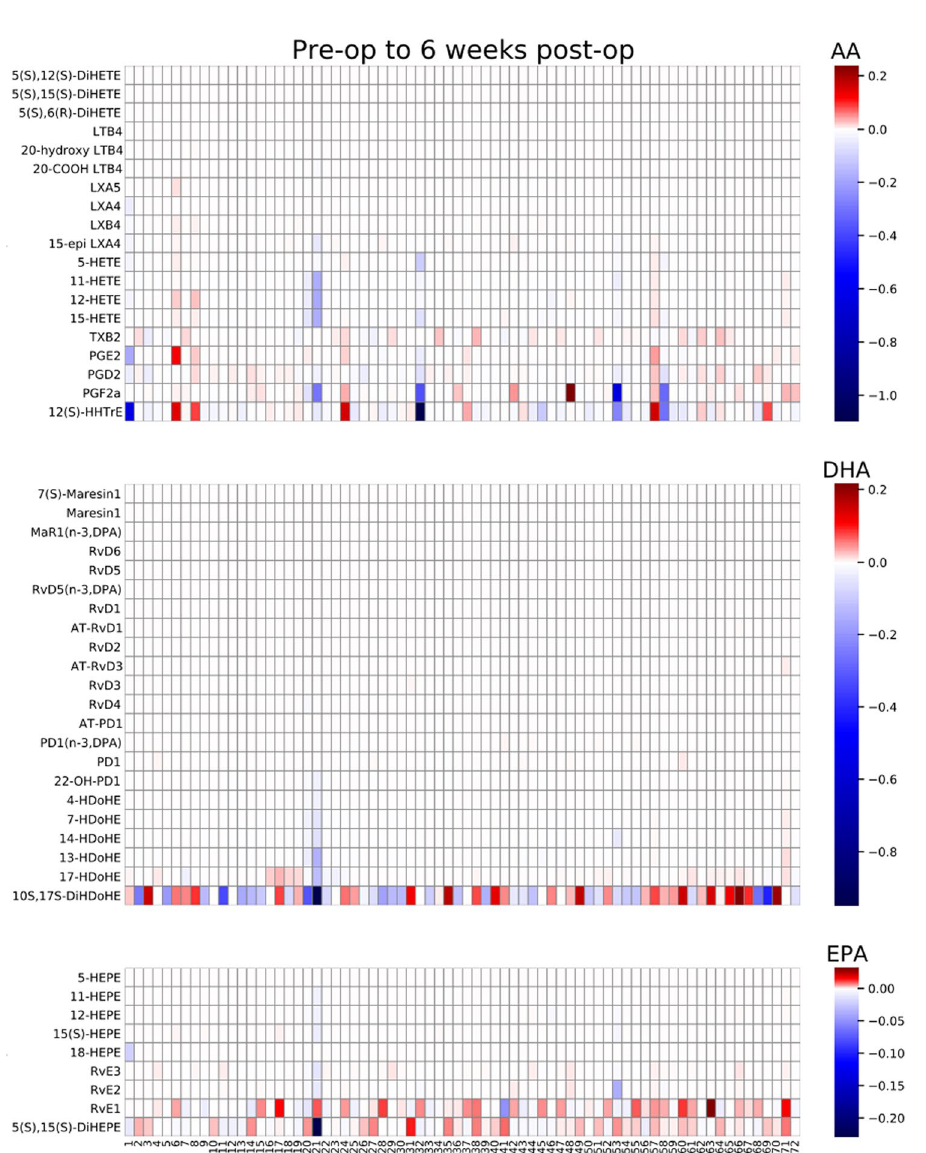
Figure 2. Non-centrifuged CSF heatmaps for AA, DHA, and EPA derived metabolite pathway changes from pre-op to 6 weeks post-op (N = 72). Patients are listed as numbers on the x-axis for each heatmap. Heatmap scale numbers represent natural log ratios of analyte concentrations from pre-op to 6 weeks